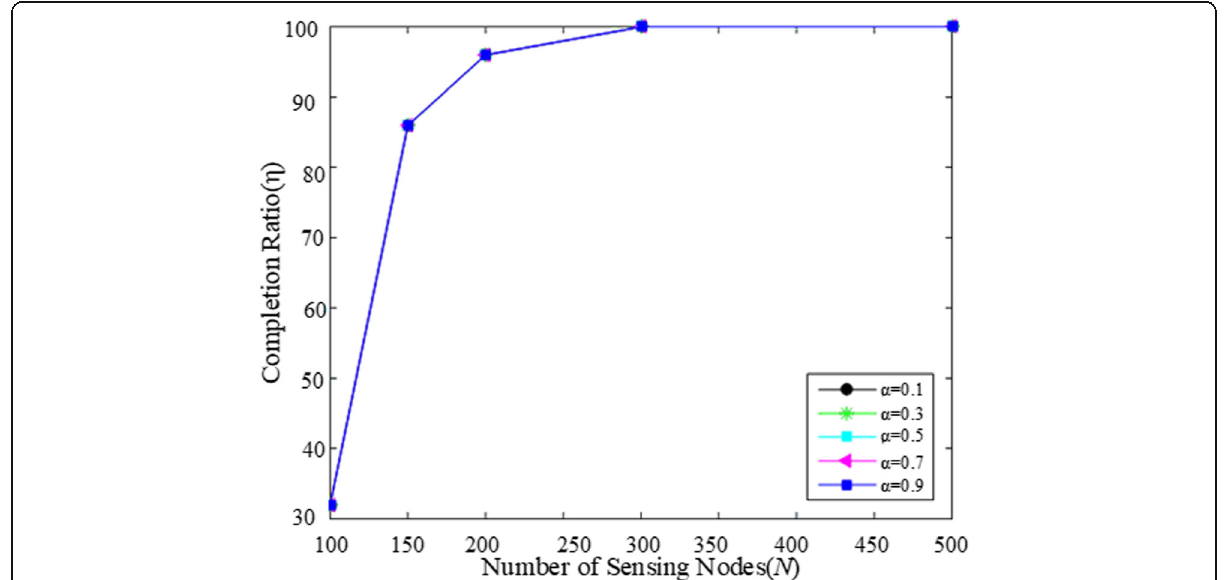
Fig. 4 Task completion ratio comparison of LCBPA with different α varying from 0.1 to 0.9 when k = 20 under different network